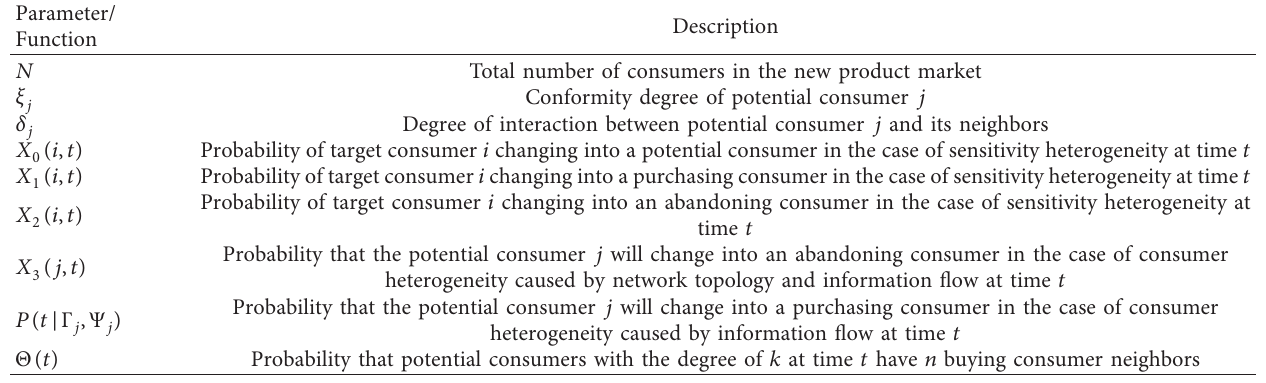
Table 1: Description of the parameters and functions used in the